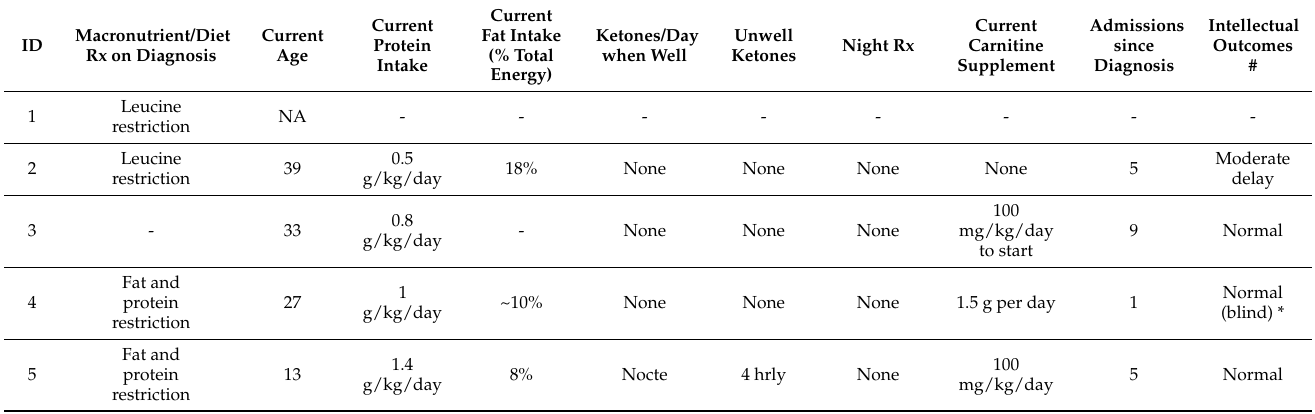
Table 2. Treatment and outcome of patients with HMG-CoA Lyase